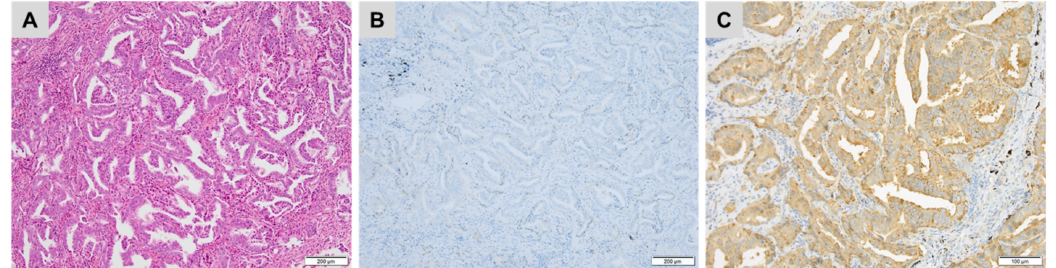
Figure 7. A metastatic prostatic adenocarcinoma ( A ) haematoxylin, eosin and safran) showing ( B ) no staining for prostate-specific antigen (PSA) but ( C ) diffuse, strong cytoplasmic staining for prostatic specific acid phosphatase (PSAP) (( B , C ) immunoperoxidase).